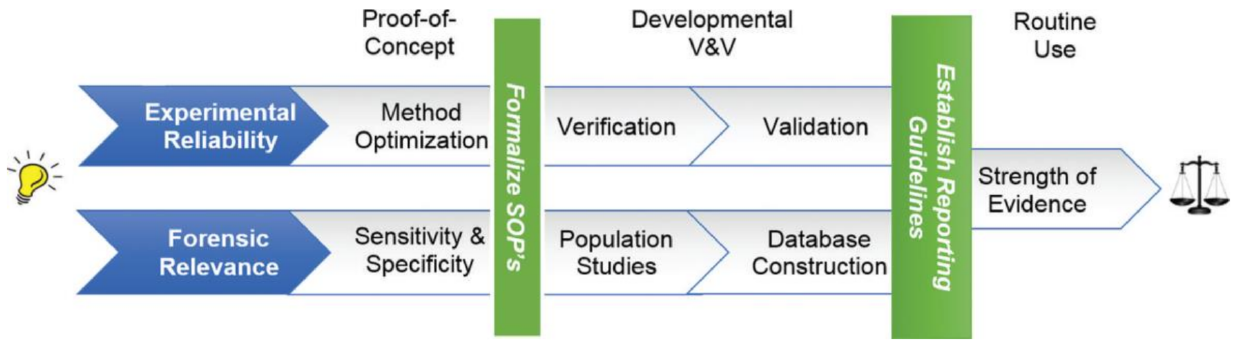
Figure 7. The forensic method development process. Reprinted with permission from [178]. Copyright (2019) American Chemical